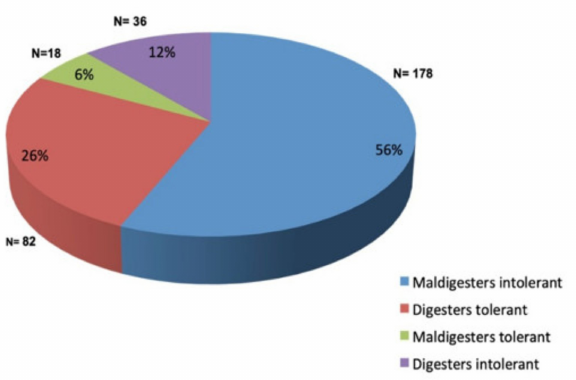
Figure 1. Classification of the patients according to the results of the lactose hydrogen breath